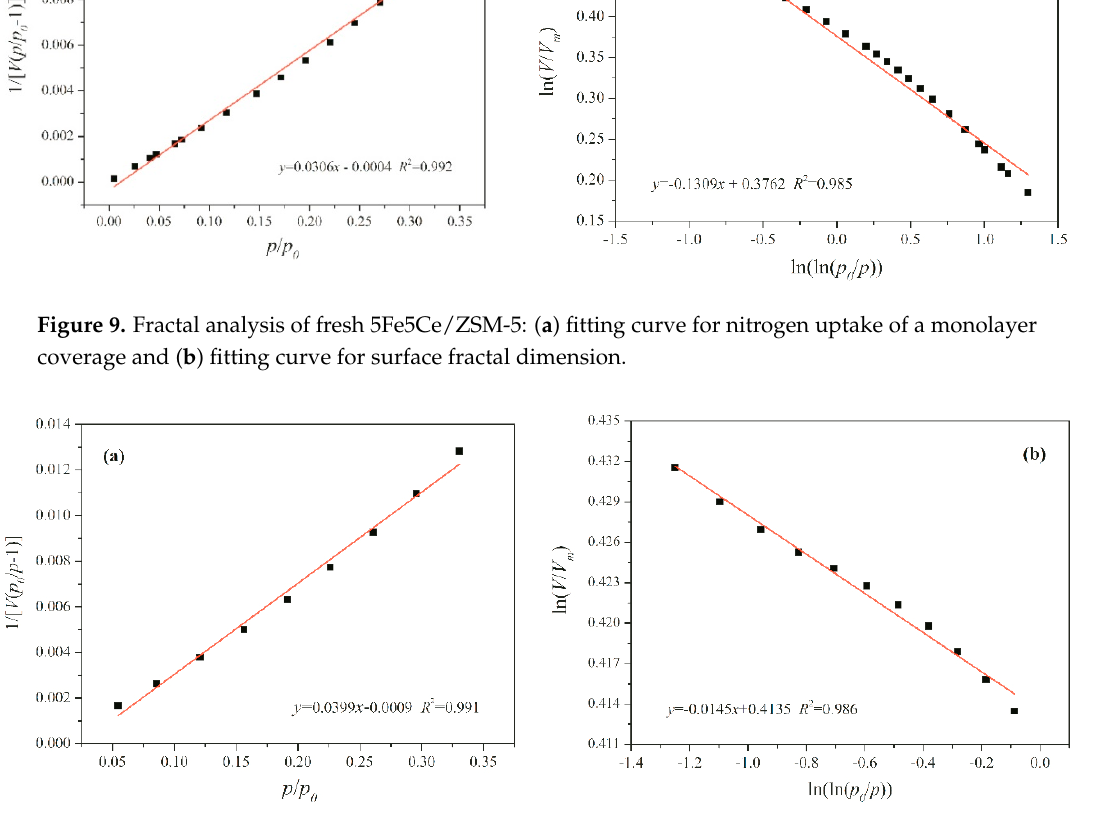
Figure 10. Fractal analysis of spent 5Fe5Ce/ZSM-5: ( a ) fitting curve for nitrogen uptake of a monolayer coverage and ( b ) fitting curve for surface fractal dimension.